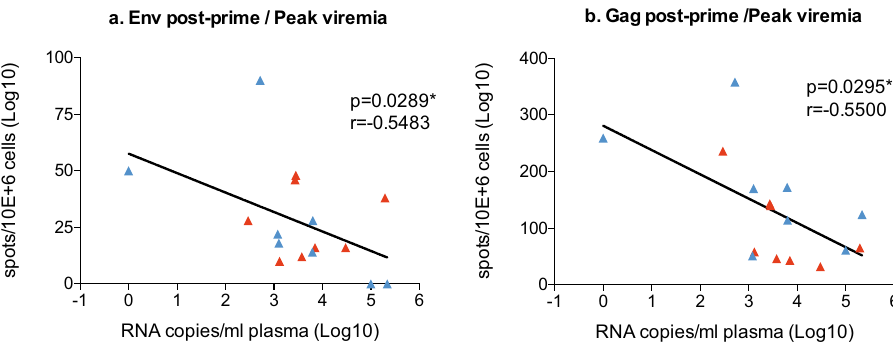
Fig. 5 Correlation between SHIV viremia control and cellular immune responses. a , b Correlation measurements: plotted data of log SHIV RNA copies/mL at viremic peak with post-prime IFN- γ -producing cells speci fi c to Env ( a ), Gag ( b ). FluoroSpot assays in vaccinated animals (MV- SHIV Wt and Mt). Statistical analyses are performed with the nonparametric Spearman correlation, two-tailed p-value. NS P > 0.05, * P <